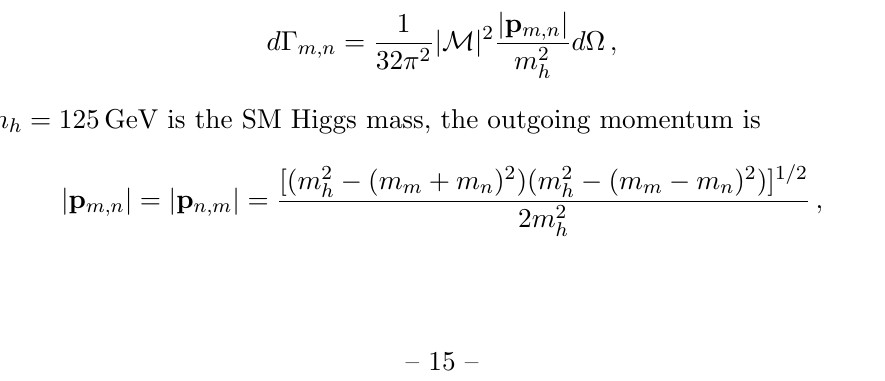
, for BM I, with m (cid:12)xed for di(cid:11)erent values of m S hS;m;n up to m S = 62 hS;m;n m ( n )